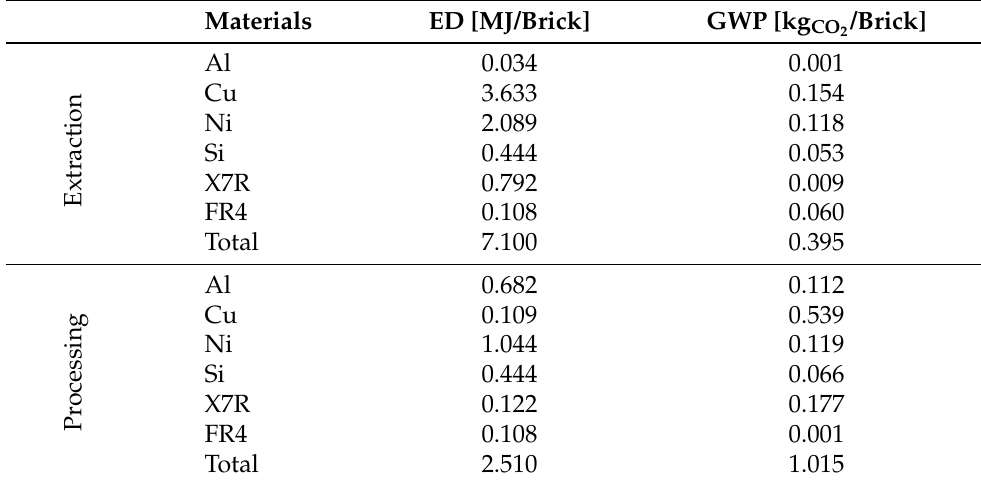
Table 8. Average ED and GWP related to the extraction and processing of the raw materials for the BMS of one brick.